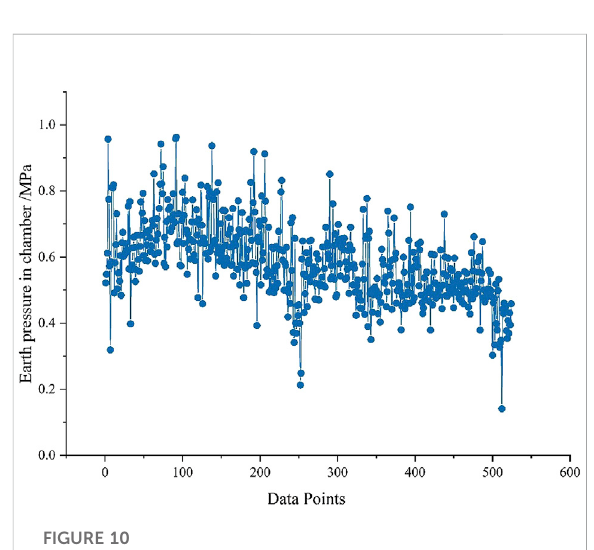
FIGURE 10 Excluding the data with large fl uctuations of chamber Earth pressure.